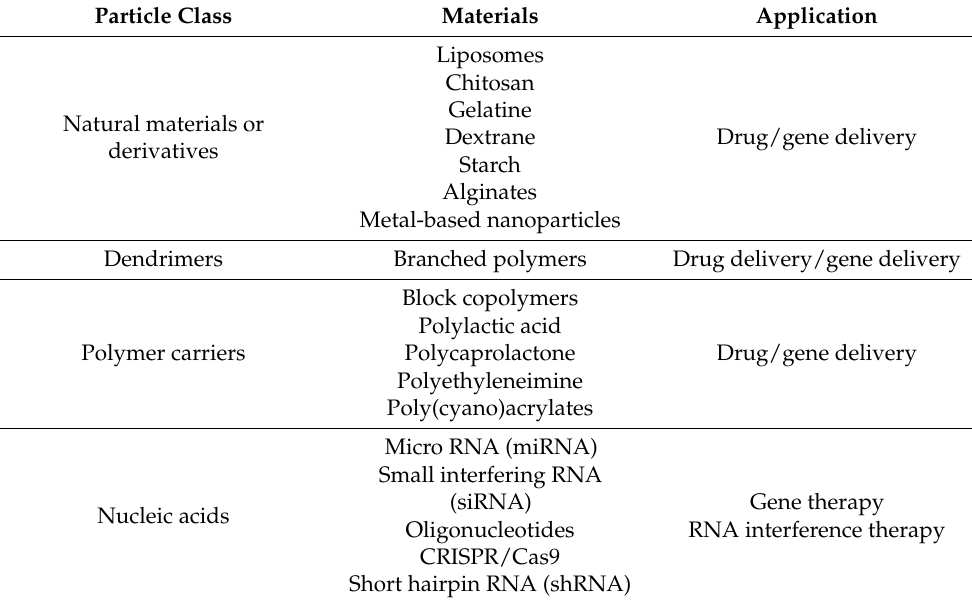
Table 2. Different types of nanoparticles investigated for drug/gene